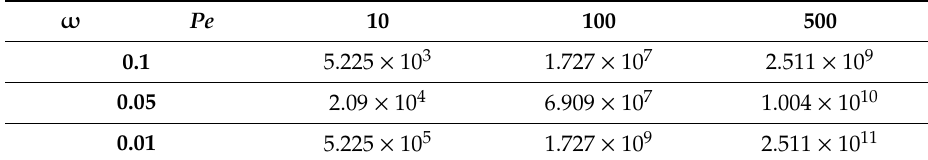
Table 1. Decay time of the ratio of two-particle to one-particle covariance. Pe: P é clet number; ω : decay percentage.